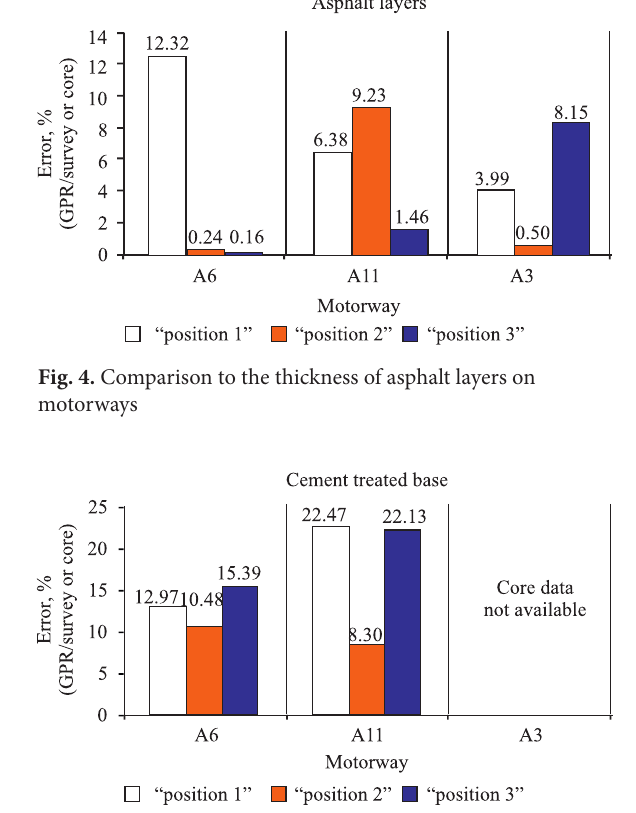
Fig. 5. Comparison to the thickness of cement treated base layers on motorways